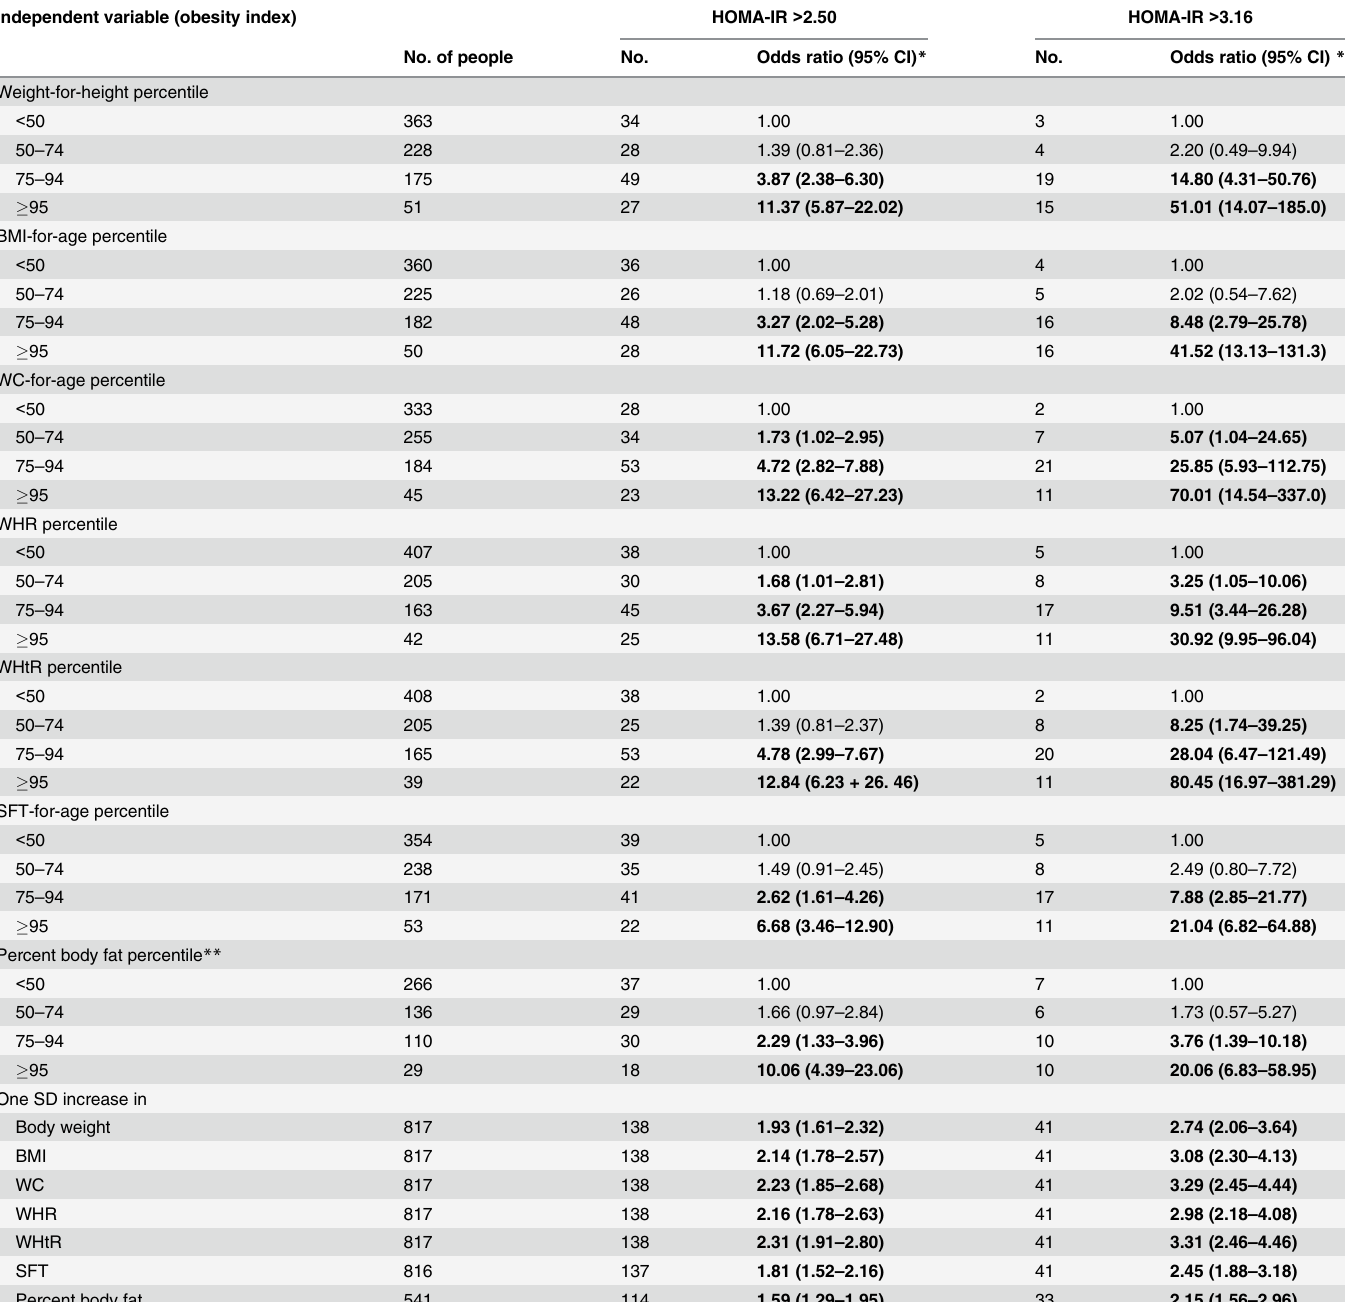
Table 4. Risk for Insulin Resistance by Different Obesity